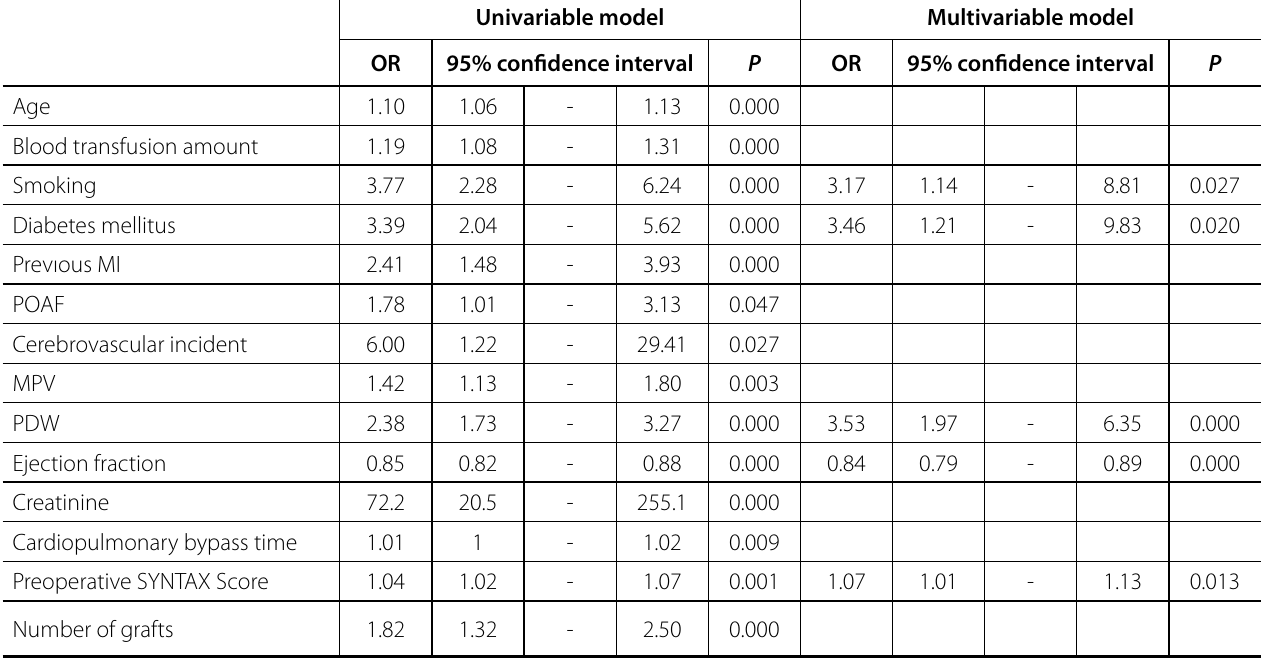
Table 4 . Logistic regression model of risk factors for saphenous vein graft failure.